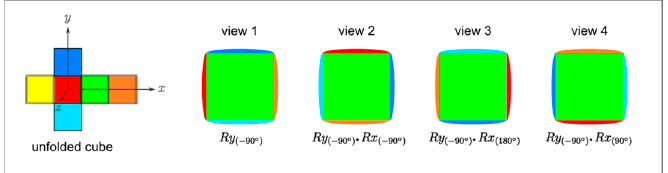
Figure 8. Distinct views for the same face.